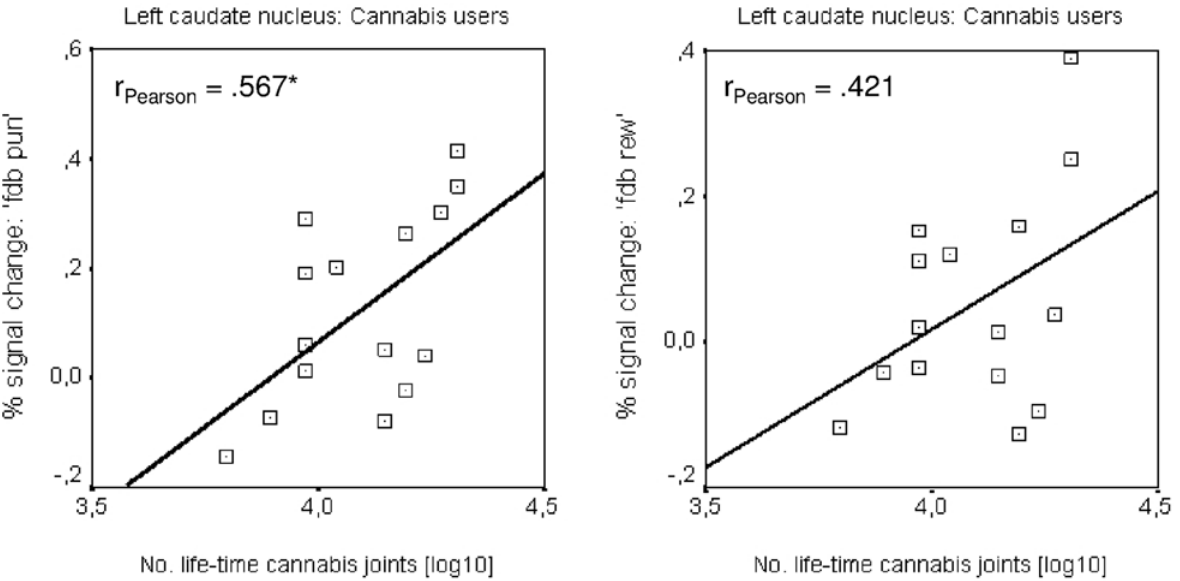
Fig 3. Correlation results. Correlation between life-time cannabis use indicated by the life-time number of cannabis joints (log-transformed) and BOLD activity derived from the left dorsal caudate during the feedback period for the conditions reward and punishment. * p <